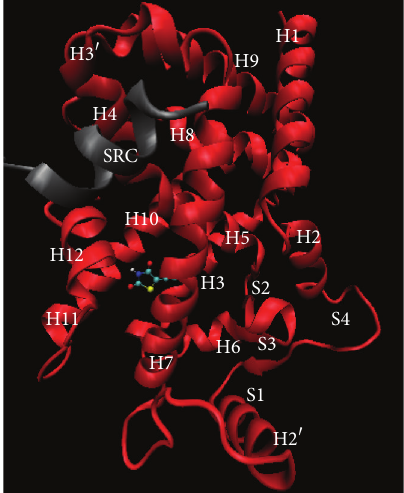
Figure 3: Crystal structure of PPAR 𝛾 (PDB: 2PRG entry), cocrys- talized with rosiglitazone (ligand) and steroid receptor coactivator 1 (SRC-1, coactivator). Figure constructed using Visual Molecular Dynamics (VMD)